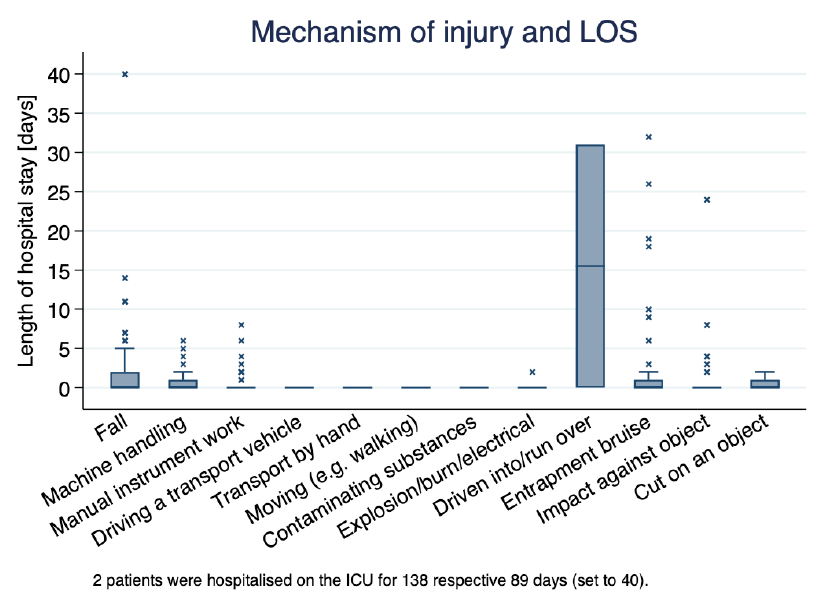
Figure 3. Relationship between the mechanism of injury and length of hospital stay. Outliers are indicated with symbol “×” .